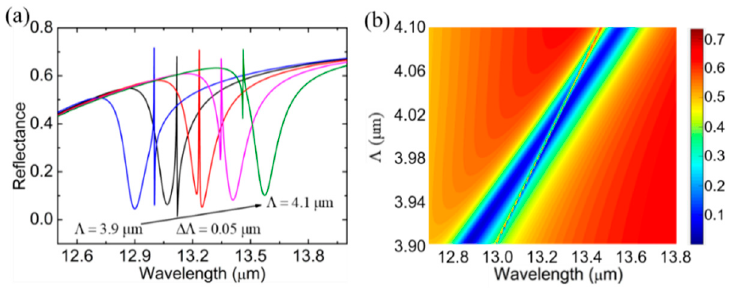
Figure 3. ( a ) The reflection spectrum of the structure when Λ changes from 3.9 to 4.1 μ m with a step size of 0.05 μ m. ( b ) The reflectance contour plot of wavelengths and Λ .